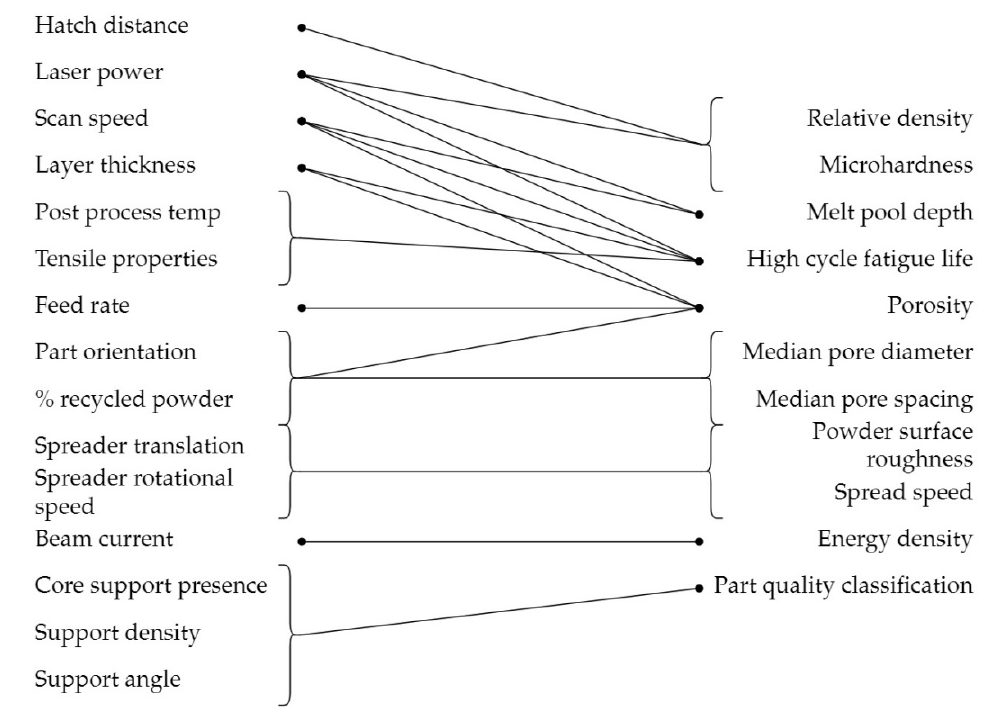
Figure 2. Matching diagram relating PBF process parameters to quality indicators from successful implementations. Adapted from Wang et al. [8].